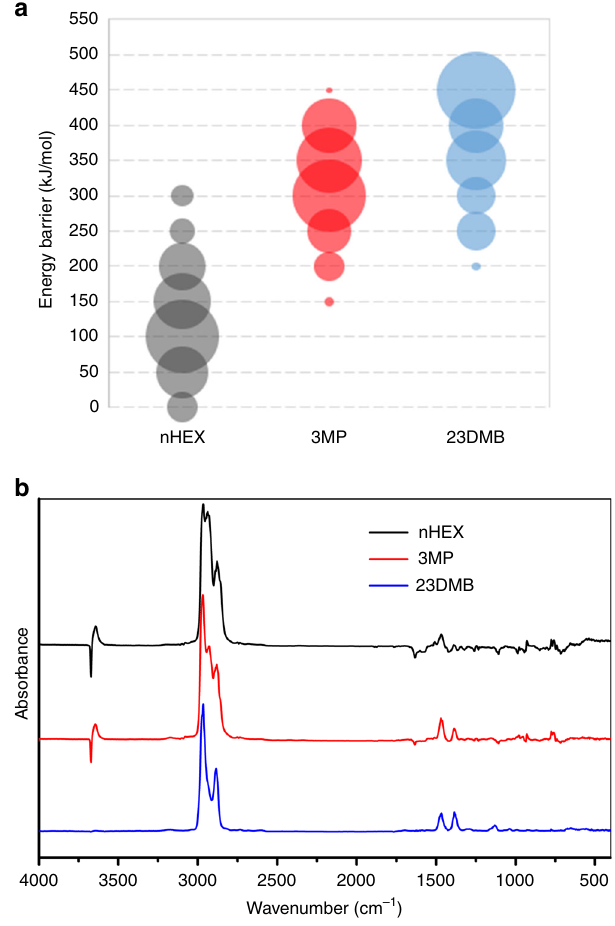
Fig. 5 Investigation of the mechanism of separation of C6 alkane isomers in compounds 1 and 2 . a Energy barriers calculated from ab initio molecular dynamics (AIMD) simulations in compound 1 to highlight vast differences in kinetic energy barrier between the linear and branched C6 alkanes. Barriers range from 0 (no barrier) to 450 kJ/mol and are broken into 50 kJ/ mol increments. The size of each circle corresponds to the amount of AIMD trajectory time in that increment. A larger circle thus indicates more AIMD time steps with a barrier in that increment range. As expected, a higher degree of branching results in higher barriers. These results con fi rm the kinetically-driven sieving mechanism at play in compound 1 . b IR spectra of compound 2 upon adsorption of three C6 alkane isomers after 3 min under 10 torr at 30 °C. All spectra are normalized by the reference spectra recorded prior to the